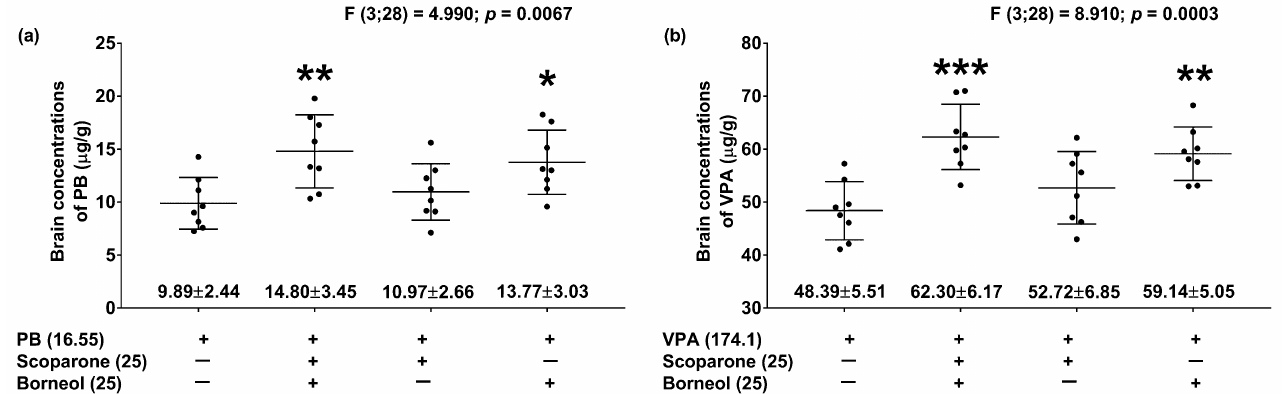
Figure 6. Influence of scoparone and borneol on total brain concentrations of PB ( a ) and VPA ( b ) in experimental animals. Scatter plots with whiskers illustrate mean concentrations (in μg/g of wet brain tissue ± SD of 8 determinations) of PB ( a ) and VPA ( b ) in the brain of experimental animals. Statistical analysis of data was performed with one- way ANOVA followed by Dunnett’s mu ltiple comparisons test. Brain tissue samples were quantified using fluorescence polarization immuno- assay. All the drugs were administered i.p. at doses corresponding to their ED 50 values from the mouse MES model. PB — phenobarbital; VPA — valproate; * p < 0.05, ** p < 0.01 and *** p < 0.001 vs.